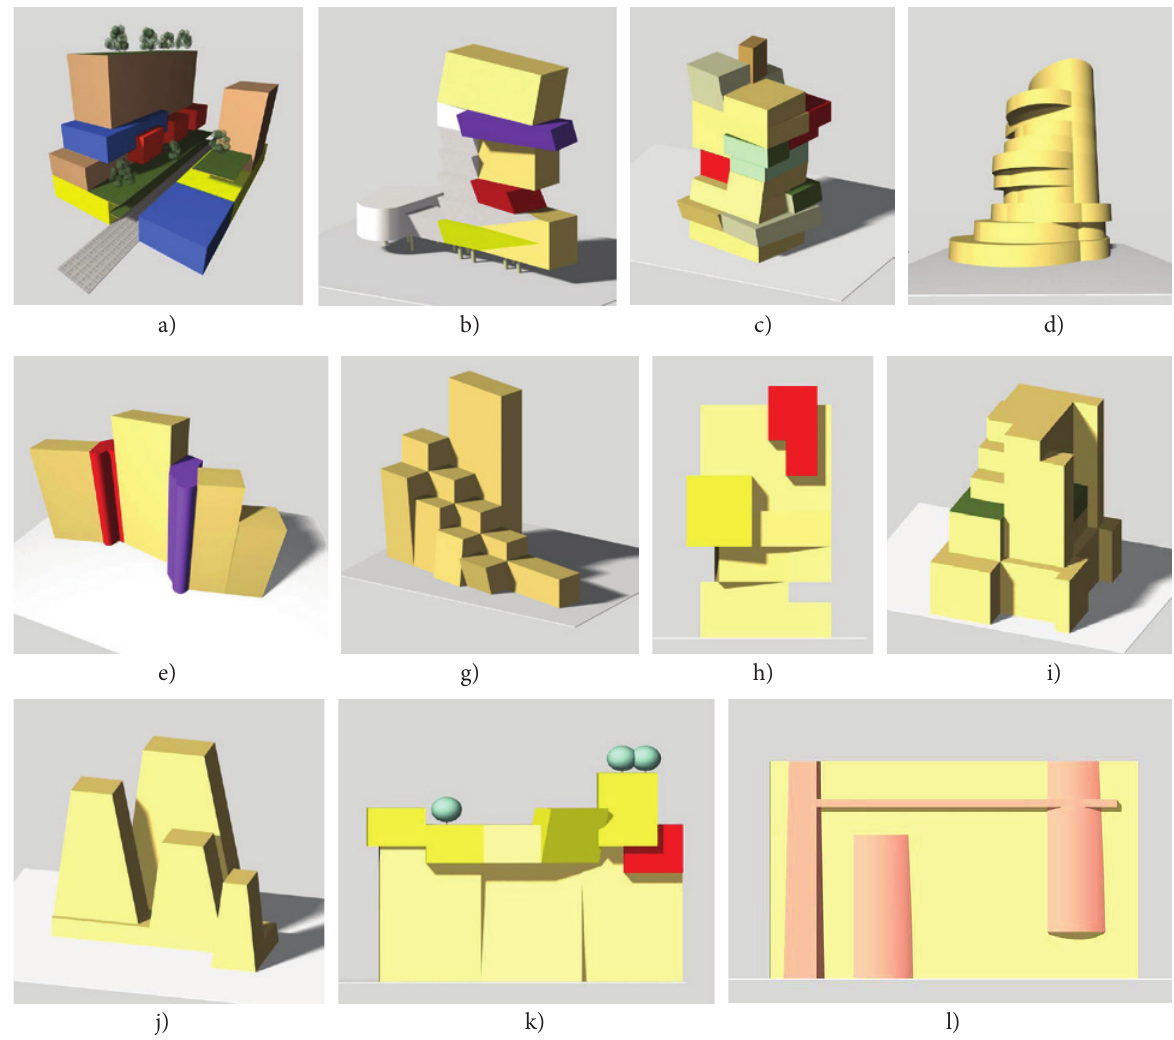
Figure 2. The principle of variability in schemas (source: author, 2013); a) mixed type of MRB; b) combination of different types of vertical and horizontal communications in the structure of the building; c) mixed planning structures of the MRB; d) terracing of the building volume; e) use of block inserts; g) volume breakdown on separate tiers; h) large vertical divisions; i) change of the number of apartments in high-rise levels; j) separate tiers with free floors or free ruptures between volume parts; k) selection of the last floors of the house; l) differentiated approach to use of summer premises by types and principles their rhythmic placement on the façade